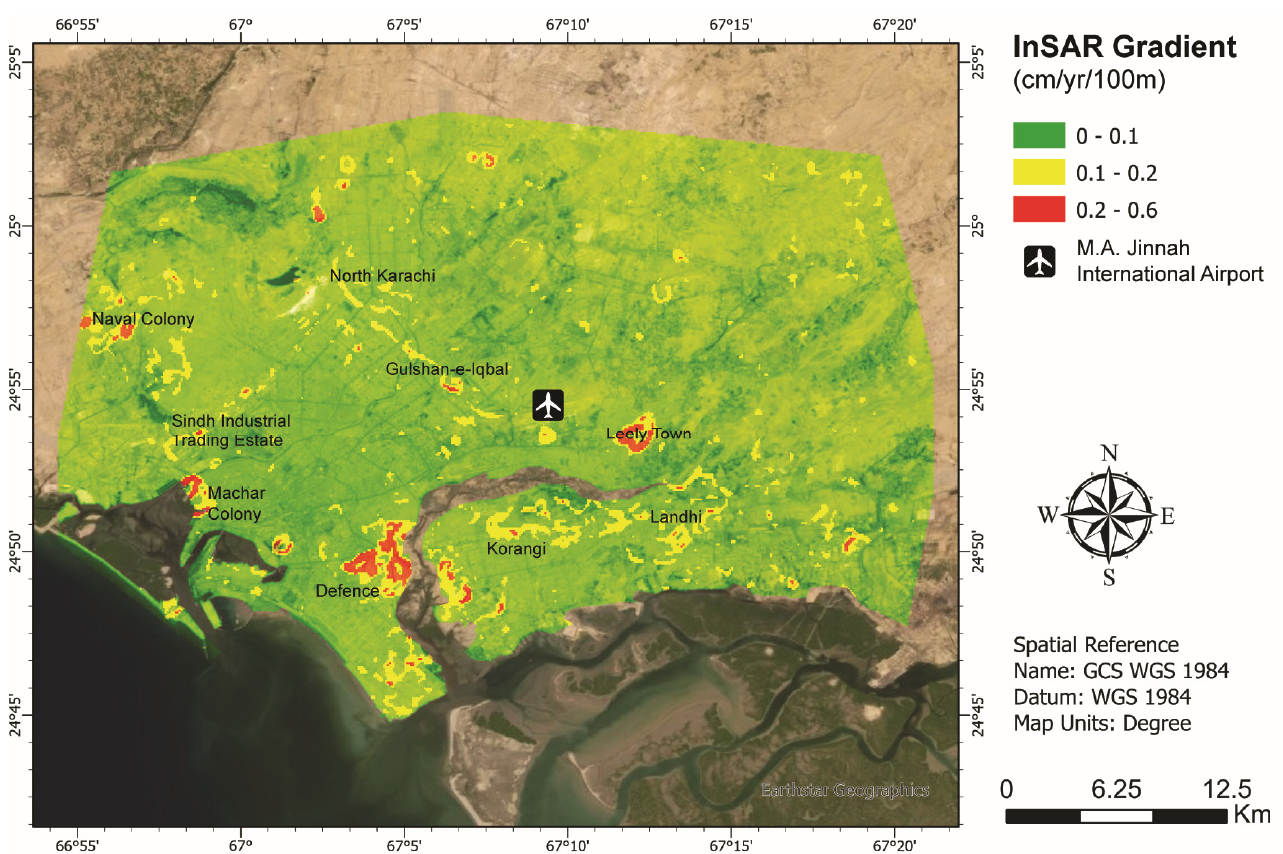
Figure 11. InSAR gradient created using vertical displacement data.